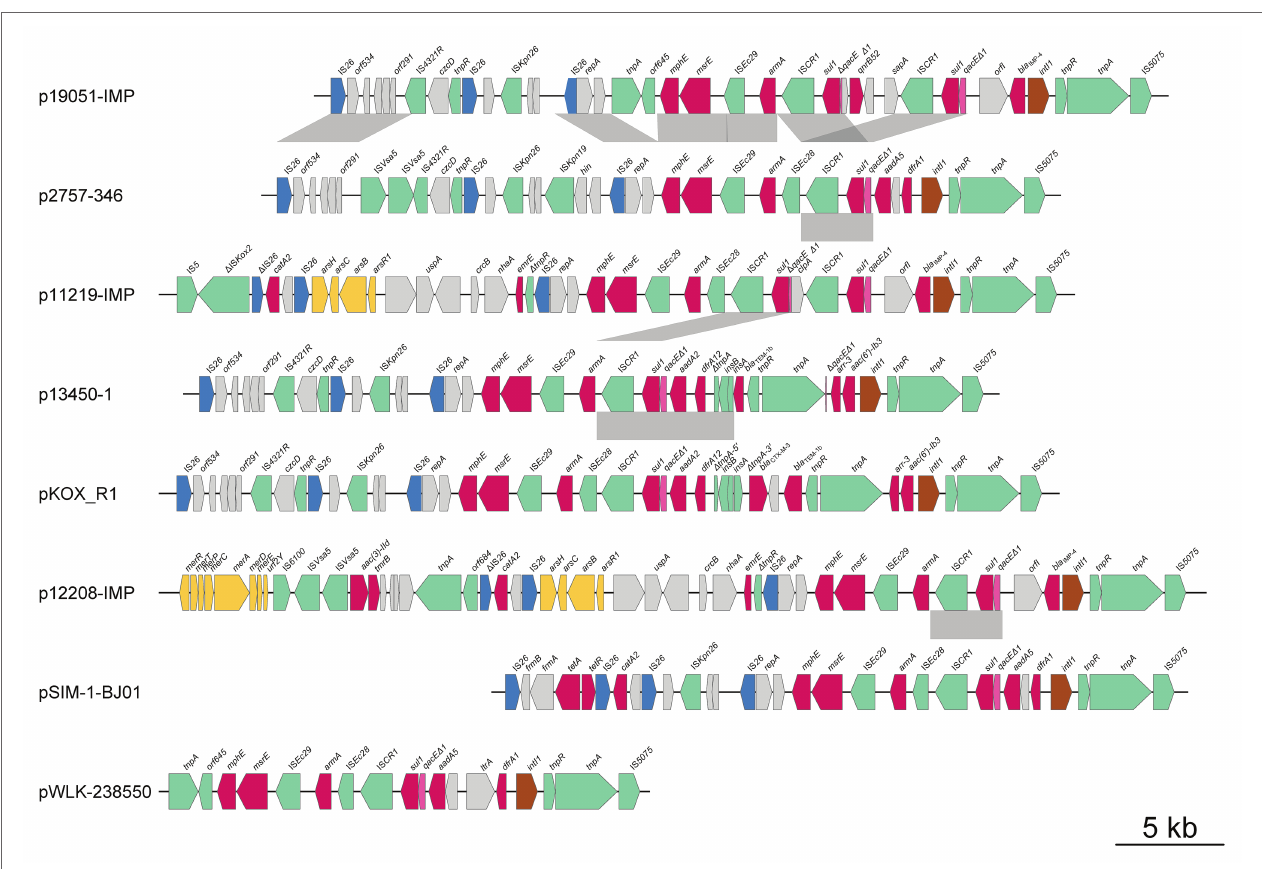
FIGURE 4 | Comparative genomic analysis of antibiotic resistance island A (ARI-A). Mobile elements are shown by green, brown, and blue arrows. The red arrows indicate antibiotic resistance genes, the pink arrows denote biocide resistance genes, and the gray arrows represent genes of other functions. The shading indicates 100% nucleotide sequence